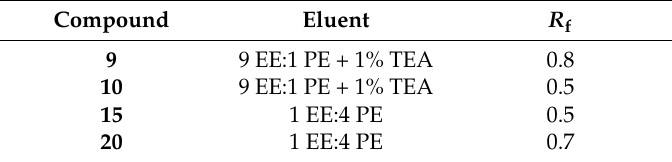
Table 3. R f -values of relevant reference compounds for radio-thin layer chromatography (TLC) analyses.